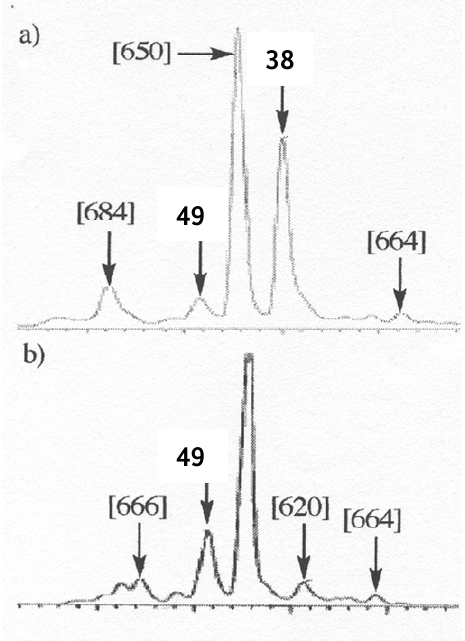
Figure 12. Chromatographic profiles of the oxidation reaction mixture at 3 hours of 38 (a) and 49